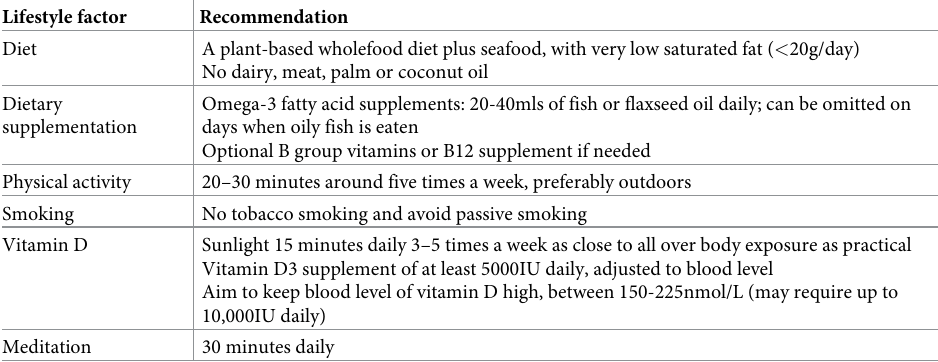
Table 1. Lifestyle recommendations of the